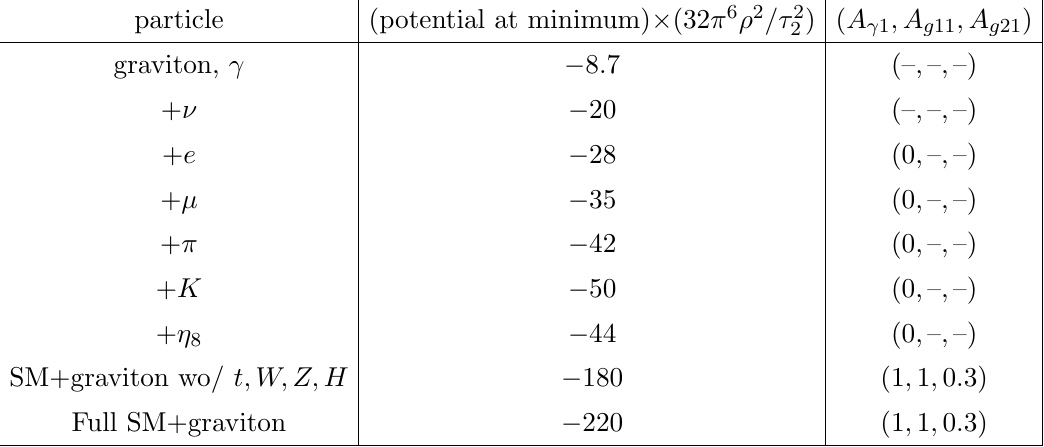
Table 5 . Same as (cid:12)gure 4, but for anti-periodic, Majorana neutrinos. particle